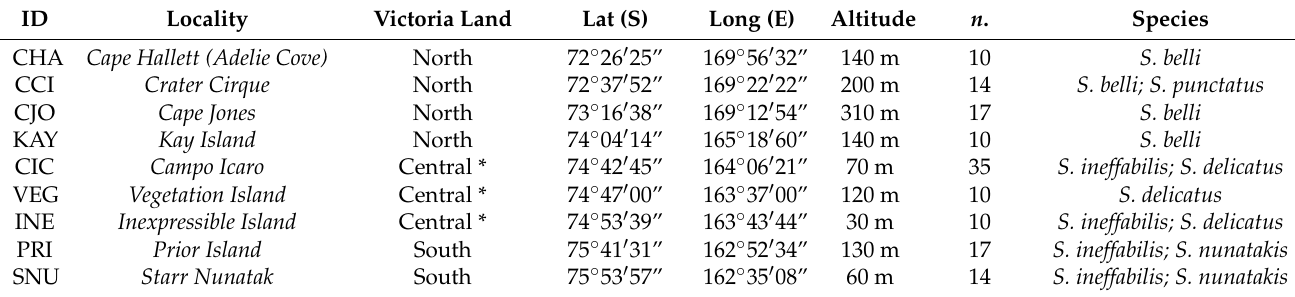
Table 1. Coordinates and altitudes of sampling localities and ID codes for the different populations sampled; the numbers of individuals ( n .) extracted and used for the molecular analyses and the species found at each locality, are given. ID